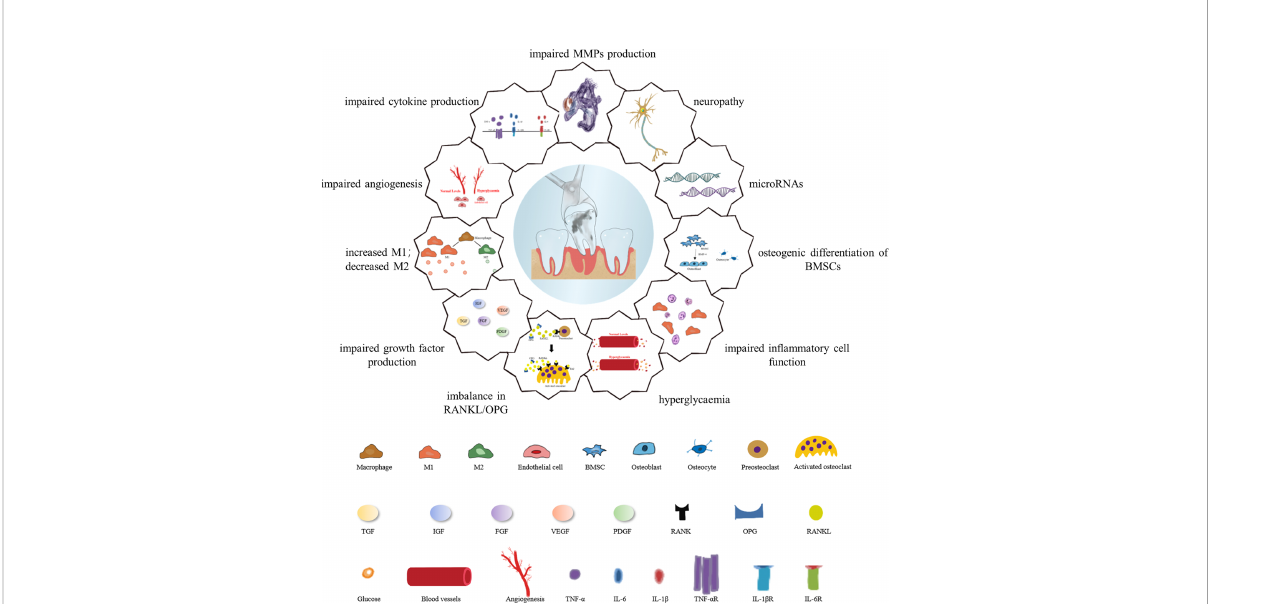
FIGURE 2 Factors responsible for the healing process of diabetic extraction sockets. Diabetes inhibits mitotic growth factor expression through epigenetic mechanisms; dif fi culty in wound healing after tooth extraction is associated with diminished osteogenic differentiation of mesenchymal stem cells, activation of matrix metalloproteinase-9, persistent imbalance of RANKL/OPG ratio, and reduced expression of neuropeptides. Hyperglycemia affects hormone receptor conversion as well as the formation of new blood vessels, and impaired angiogenesis not only hinders bone formation but also affects the rate of wound healing. Diabetic wounds are characterized by chronic in fl ammation due to high levels of reactive oxygen species, dysregulated M1/M2 macrophage polarization, and pro-in fl ammatory chemokines. High glucose levels have a negative impact on macrophage function, mainly in the form of dysregulated levels of cytokine secretion such as TNF- a , IL-6 and IL-1 b , in addition to the inability of neutrophils to function in the in fl ammatory response phases of wound healing, migration, chemotaxis and adhesion. MicroRNAs also in fl uence the different phases of diabetic wound